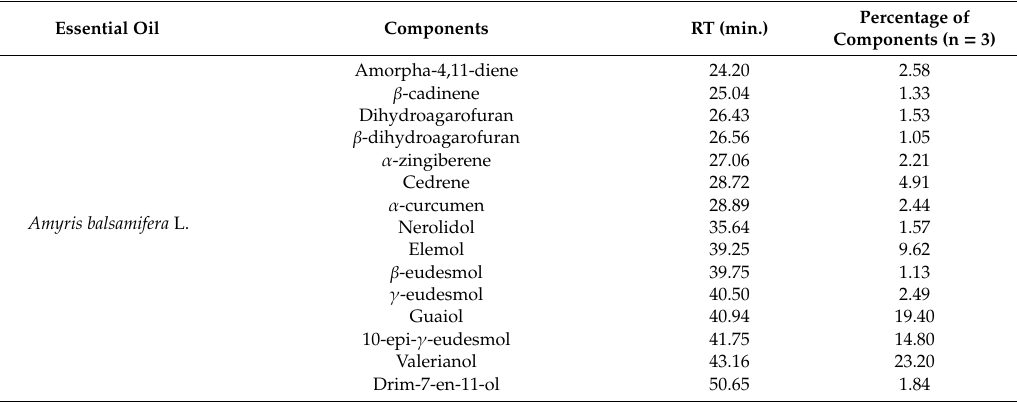
Table 1. Chemical composition of essential oil (%) *.